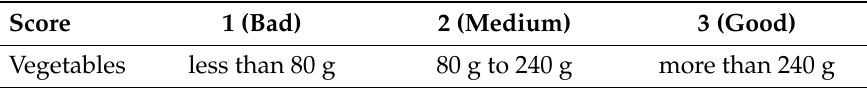
Table 2. Diet quality scores from the vegetable